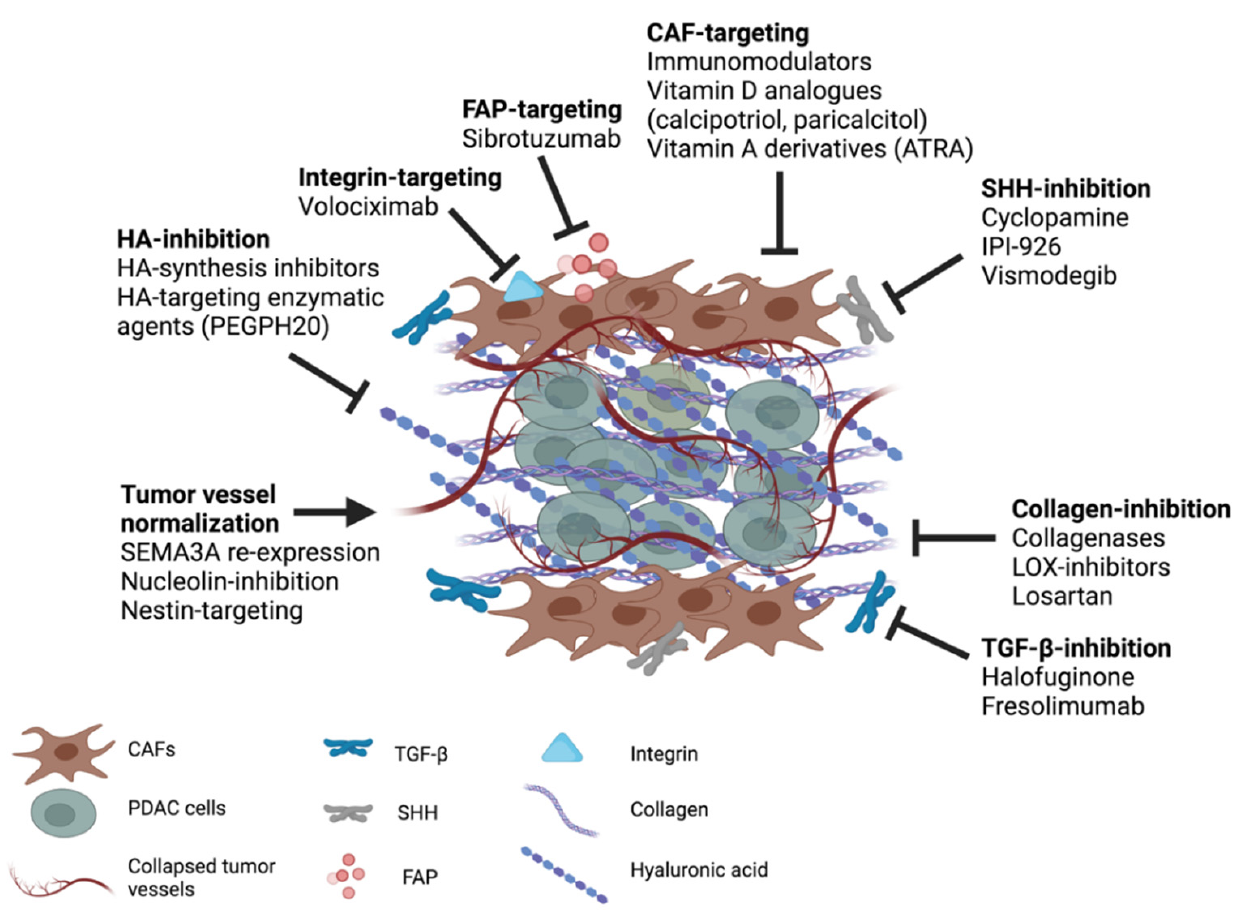
Figure 4. Schema of the principal drugs and pharmaceutical tools used and proposed for targeting the different components of PDAC stroma.